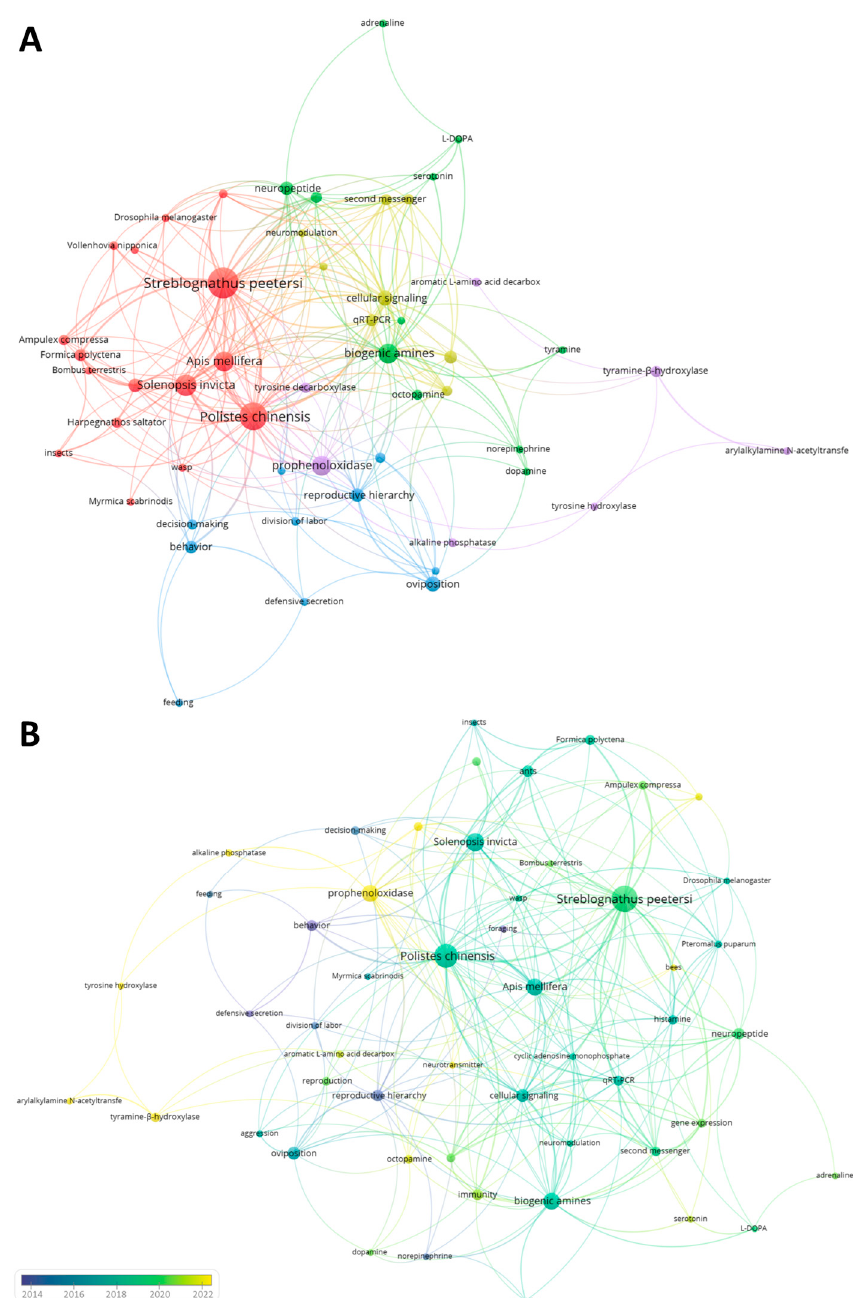
Figure 5. Co-occurrence map showing the existing networking of terms reported as keywords in publications related to the role of biogenic amines in social insects. Panel A shows the grouping of the selected terms into five different semantic groups (cluster I: red dots; cluster II: green dots; cluster III: blue dots; cluster IV: violet dots; cluster V: yellow dots). Panel B shows the same network from a temporal perspective. The blue-dark bubble is associated with terms when their involvement is less recent, while the yellow bubble refers to words that have been used in recent times. For both panels, the size of the nodes indicates their frequency. The curves between the nodes represent their co-occurrence in the same